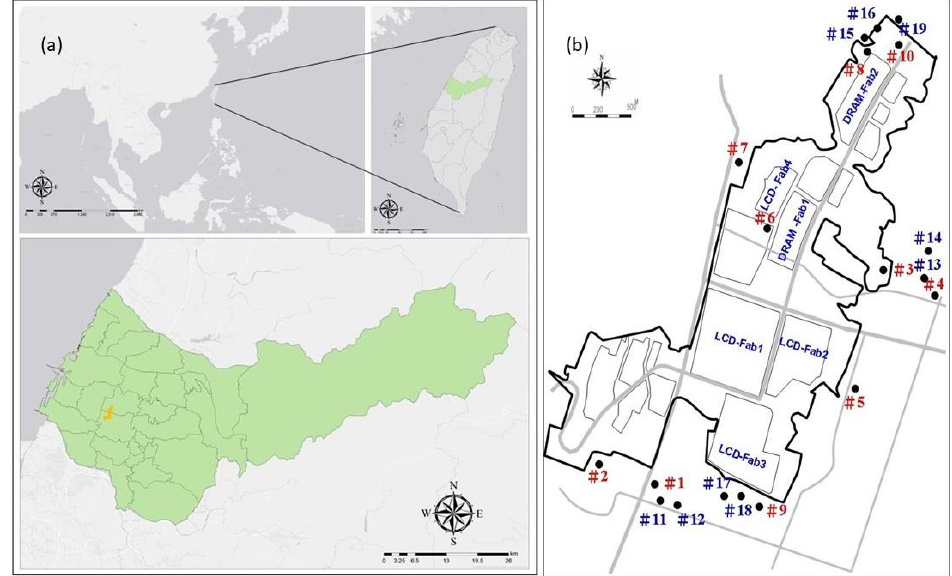
Figure 1. ( a ) Locations of the Central Taiwan Science Park (CTSP) in Taiwan; ( b ) outdoor (#1–#10, n = 10) and indoor (#11–#19, n = 9) sampling sites set up around the CTSP. DRAM—dynamic random